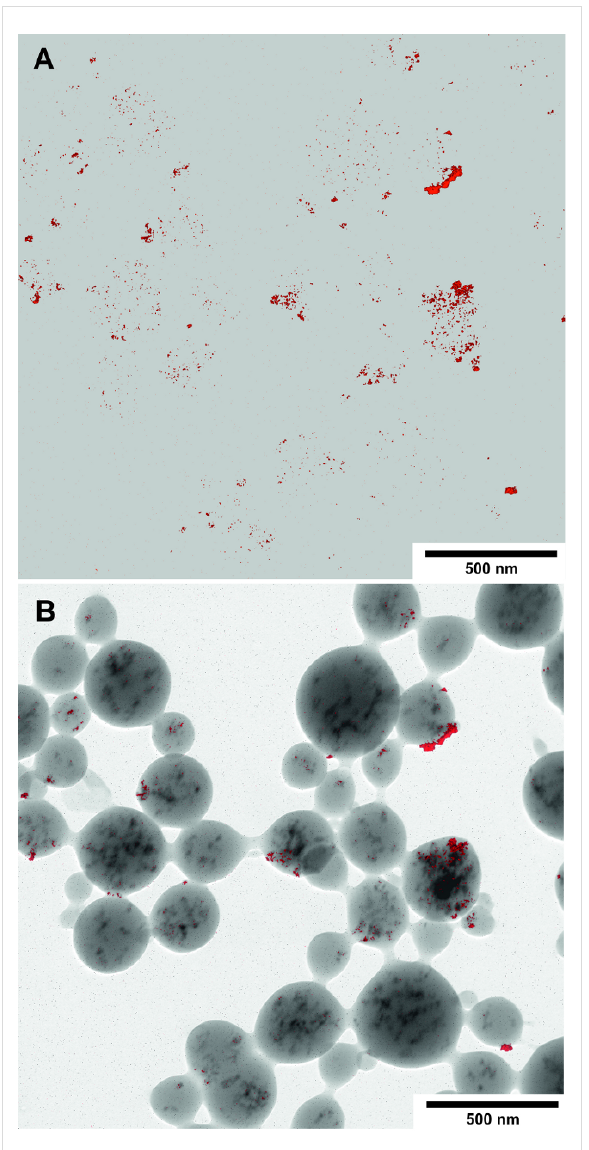
Figure 12: ESI Fe distribution maps of CEP-3 with iron oxide nanopar- ticle (Table 3, entry 1). (A) Net Fe, shown in red. Because of the signal dimensions, much of the signal intensity is lost, leading to only a weak mapping signal within the corresponding particles; (B) Fe map (red) overlaid on the zero-loss